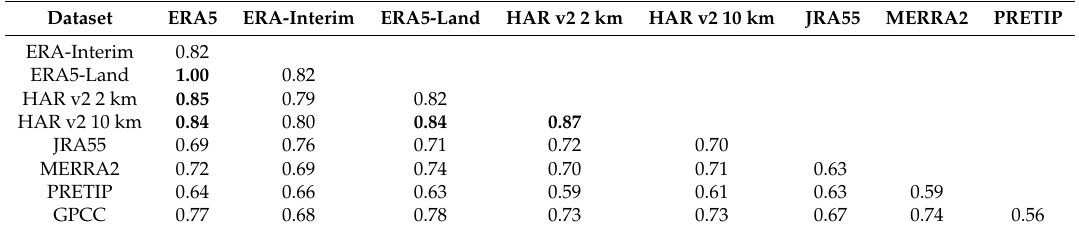
Table 5. Correlation coefficient R for all datasets in mm/5days . The five highest correlations are highlighted with bold font. All correlations are statistically significant at the 99% confidence interval.